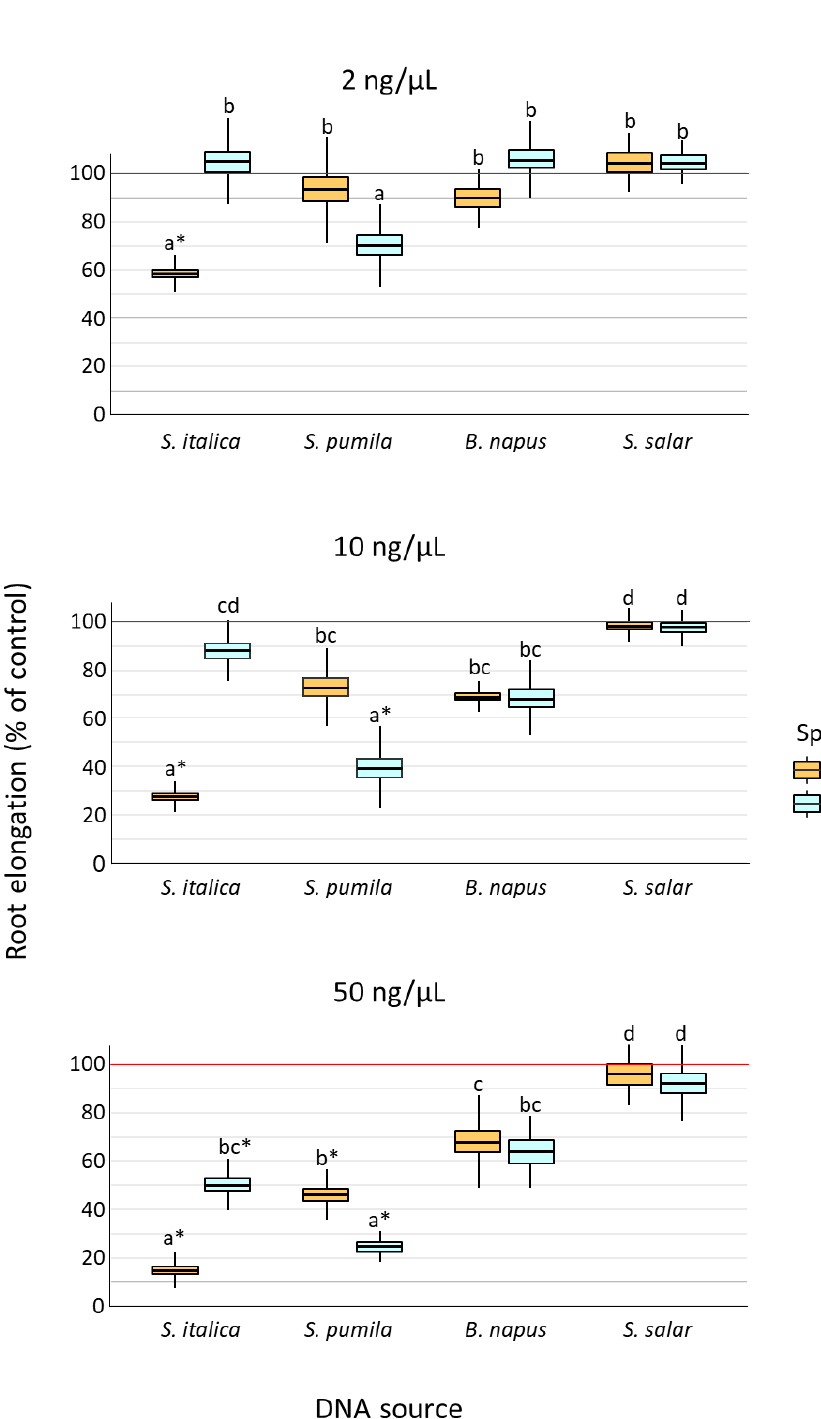
Figure 1. Effects of the treatment solutions containing DNA from different sources ( S. italica , S. pumila , B. napus , S. salar ) at three concentrations (2, 10, and 50 ng/ µ L) on the root elongation (% of control = 100, horizontal red lines) of S. italica and S. pumila seedlings after 4-day exposure in controlled conditions. Data refer to mean ± 1 standard error (box) and 95% confidence limits (whiskers) of 3 replicates for each treatment combination. Different letters above bars indicate significantly different means within each panel (Tuckey’s test, p < 0.05. Detailed results in Supplementary Table S2). Asterisks indicate root elongation inhibition as compared to the control (one-sample t test with Bonferroni’s correction for multiple comparisons).